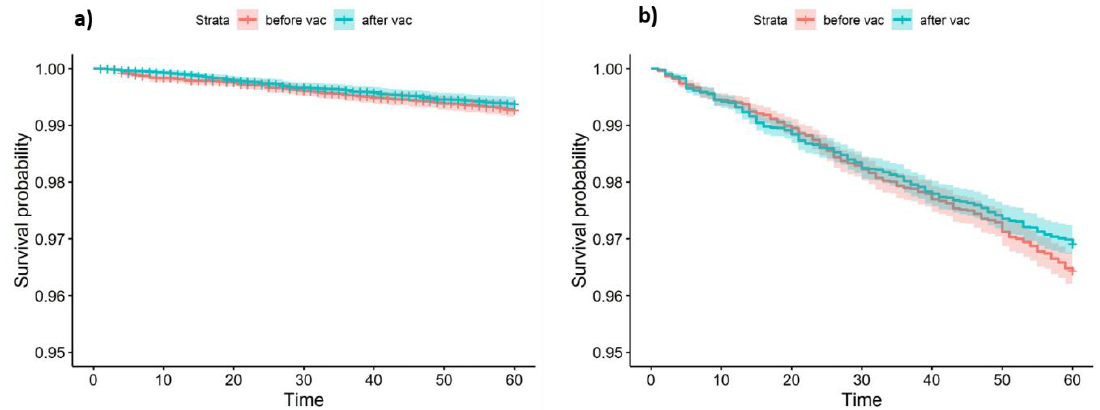
Figure 5. Kaplan-Meier survival curves as a function of vaccination status in 73 dairy cattle farms in Israel. ( a ) Event defined as in-farm death or urgent culling. ( b ) Event defined as in-farm death, urgent culling, or routine culling. Table 2 . Multivariable Cox regression analysis results in 73 dairy cattle farms in Israel. Event is defined as in-farm death or urgent culling .